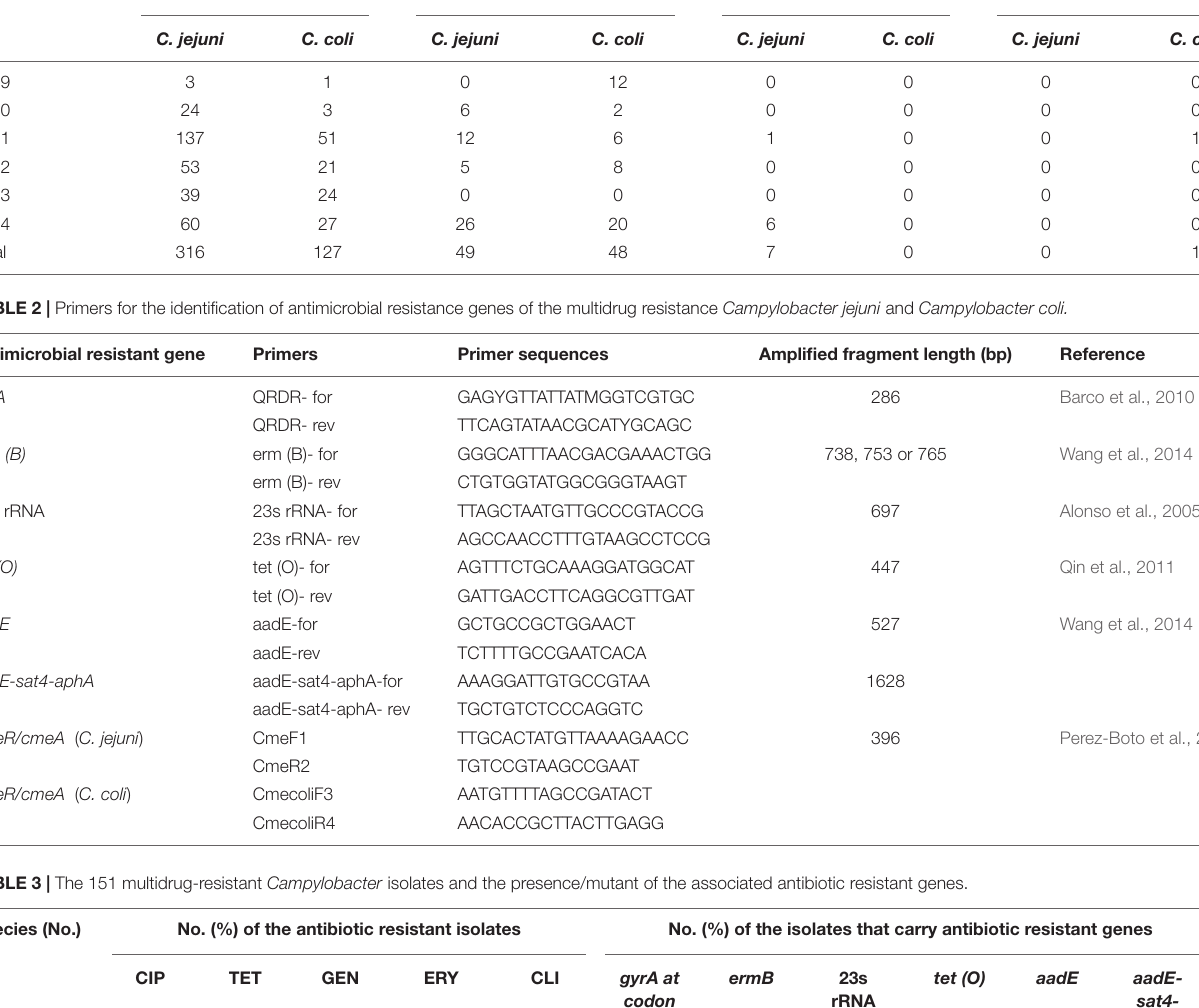
TABLE 1 | Sources of the 548 Campylobacter isolates from 2009 to 2014. Isolated year